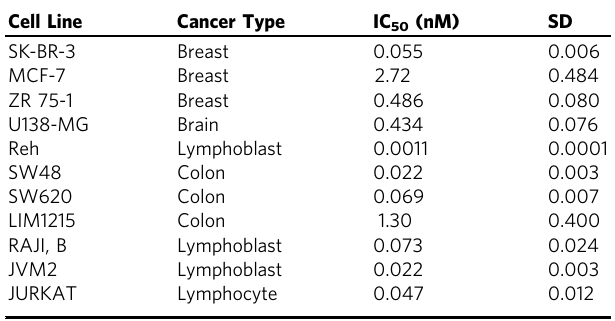
The results represent an average value of three determinations for each cell line (Standard Deviations provided in right-hand column).